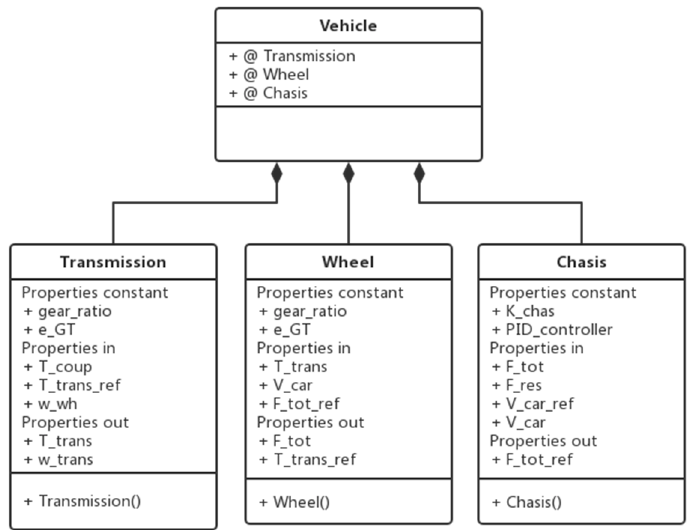
Figure 9. Unified modeling language (UML) of vehicle OOP model (power transmission).